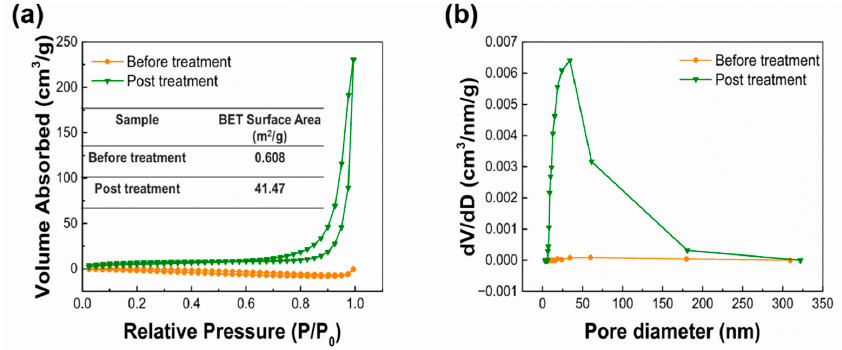
Figure 11. ( a ) N 2 adsorption-desorption isotherm graphs of PLLA fibers before and after acetone treatment. ( b ) Pore diameter distribution curves of PLLA fibers before and after acetone treatment.